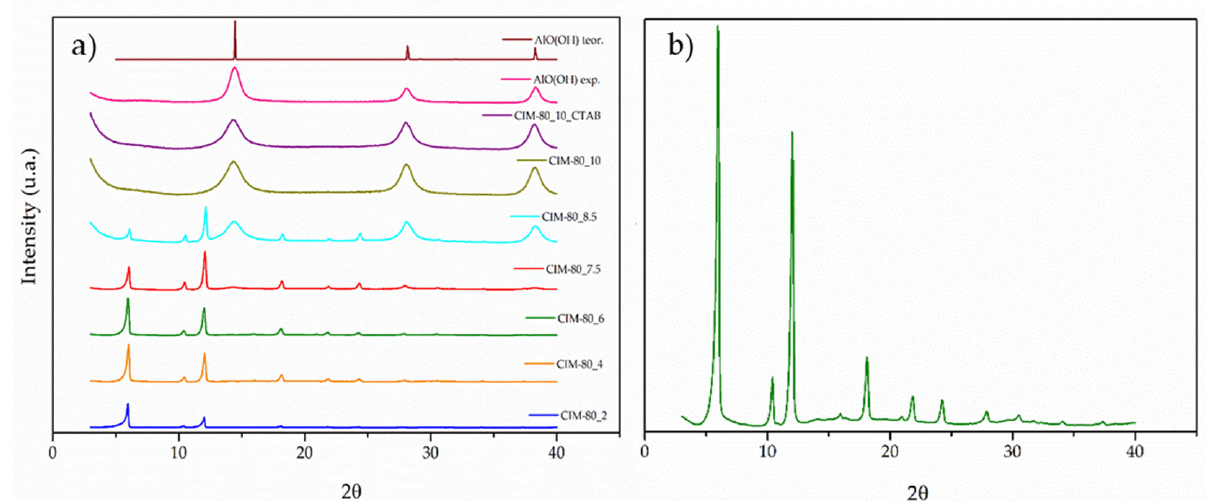
Figure 2. ( a ) X-ray diffraction pattern of the synthesized material; and ( b ) diffraction pattern of the CIM-80_6 sample.